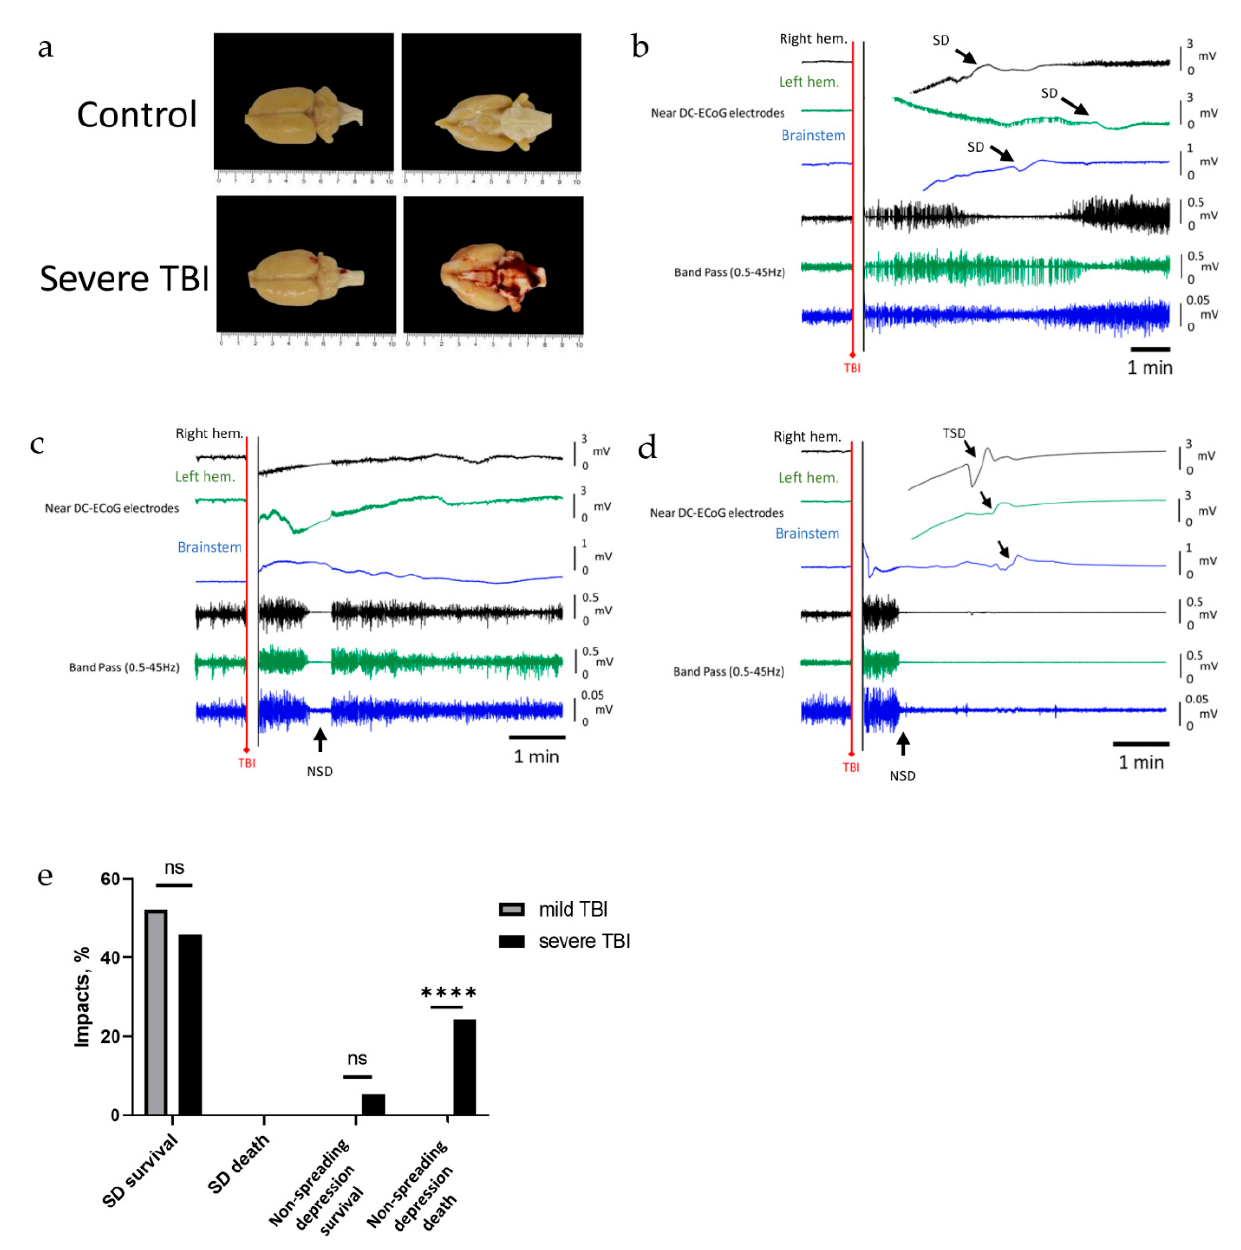
Figure 3. The electrophysiological changes in brain hemispheres and brainstem following severe TBI. The first two traces represent raw ECoG recordings (band-pass: 0.02–100 Hz) from the right (black) and left (green) hemispheres, and the third trace (blue) is from the brainstem. Traces 4, 5, and 6 show brain activity (band-pass 0.5–45 Hz) of the first three ECoG traces, respectively. ( a ) Hemorrhages at the cortex and brainstem observed after severe TBI. ( b ) Recording after severe TBI shows SD and associated depression of activity in both cortical hemispheres and the brainstem. ( c ) Recording showing non-spreading depression of activity occurring simultaneously in both cortical hemispheres and the brainstem; activity returns and the rat survives. ( d ) Recording showing lasting non-spreading depression of activity followed by terminal spreading depolarizations (TSDs, arrows) in both cortical hemispheres and the brainstem, and death. ( e ) Occurrence rate of SDs and non-spreading depression in mild and severe TBI, and their association with TBI outcomes; non-spreading-depression-associated death occurs significantly more frequently ( p < 0.0001, Fisher’s exact test) in severe TBI. **** p < 0.0001.